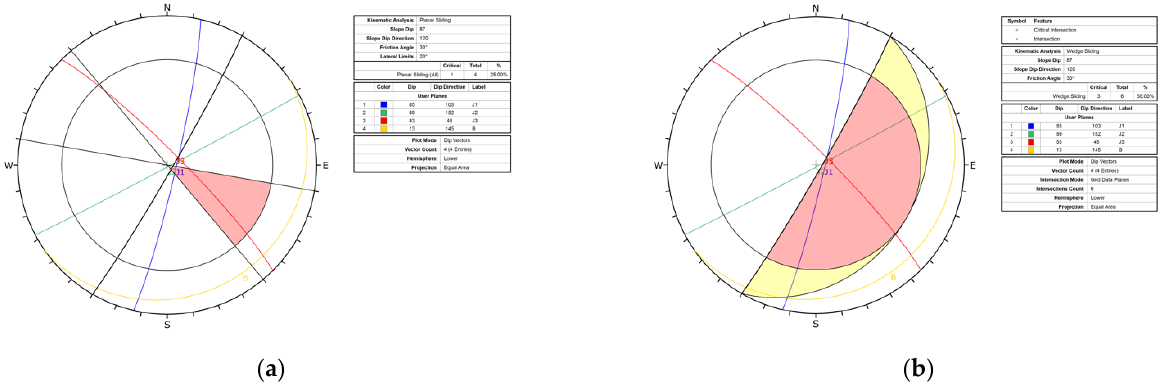
Figure 13. Kinematic analysis for: ( a ) planar sliding and ( b ) wedge sliding failure in sub-region U4.